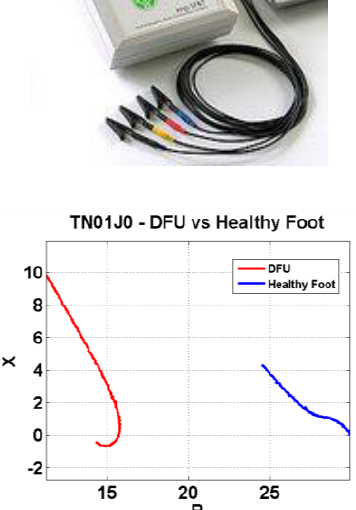
Figure 1: Overview of the BIPPED protocol: 4 point impedance measurement (top) on a Diabetic Foot Ulcer, Impedimed™ SFB7 impedance meter (middle), example of measured Nyquist plots of DFU (red) and the healthy foot (blue)